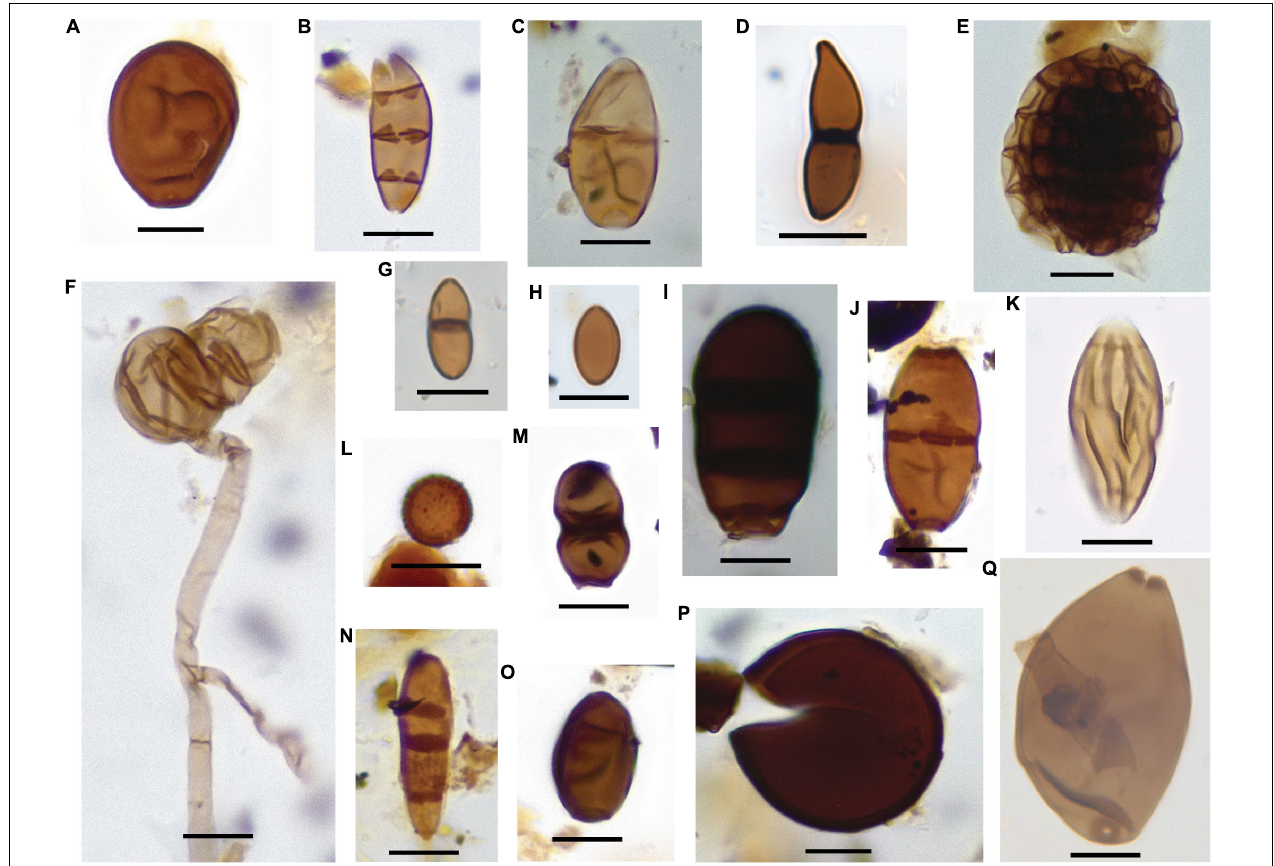
FIGURE 4 | Fungal spores found in Slovakia. Each photograph indicates: identification if any, the sample number, morphotype number (OPaL #), and England Finder coordinates (EF). (A) sample 10, OPaL 77, EF: Q49-2; (B) sample 10, OPaL 227, EF: T39-3; (C) sample 3, OPaL 243, EF: J69-1; (D) Jahnula , sample 4, OPaL 278, EF: F-33; (E) cf. Dictyosporium , sample 4, OPaL 274, EF: O41; (F) Glomeraceae (cf. Glomus ), sample 10, OPaL 226, EF: X46-1; (G) cf. Asterina , sample 4, OPaL 229, EF: D34; (H) sample 6, OPaL 78, EF: N70-1; (I) sample 3, OPaL 250, EF E65-4; (J) Ascotaiwania aff. limnetica , sample 10, OPaL 114, EF: N39-3; (K) Diporotheca , sample 5, OPaL 141, EF: M38; (L) cf. Tulostoma , sample 10, OPaL 209, EF: N40-4; (M) sample 10, OPaL 230, EF: 31-4; (N) sample 3, OPaL 233, EF: W42-4; (O) sample 10, OPaL 195, EF: C46-2-4; (P) sample 3, OPaL 250, EF: W41-2; (Q) sample 4, OPaL 194, EF: V32-3. Scale bar: 10 µ m. More information of each specimen in Supplementary Table 1